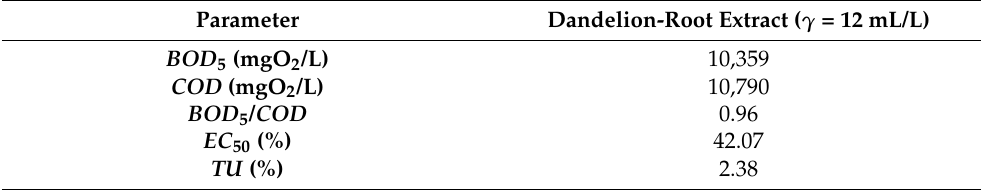
Table 7. Chemical properties and toxicity of dandelion-root extract (Adapted from